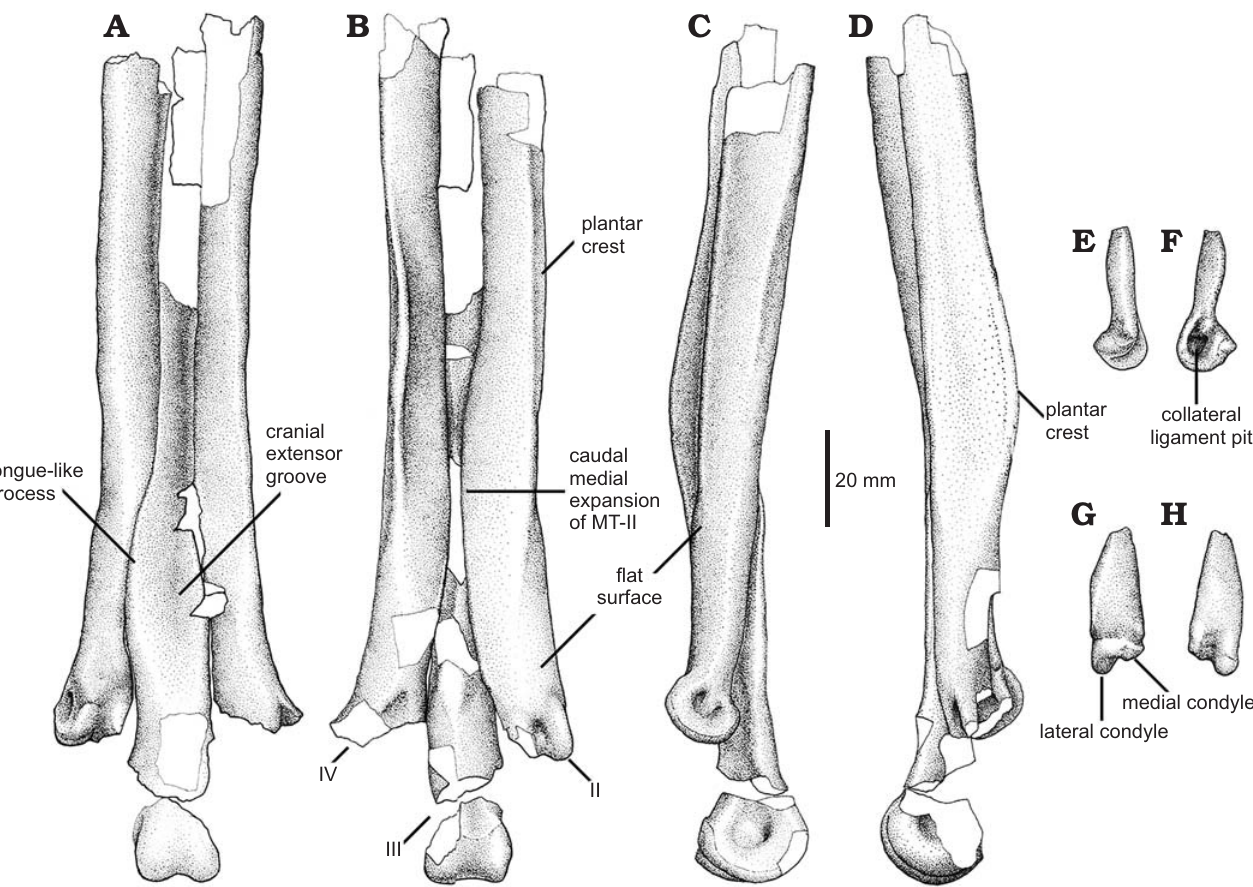
Fig. 7. Unenlagiid theropod Neuquenraptor argentinus Novas and Pol, 2005 (MCF PVPH 77) from Sierra del Portezuelo, Neuquén Province, Argentina; Portezuelo Formation, Coniacian, Late Cretaceous. A – D . Left metatarsals II–IV in cranial ( A ), caudal ( B ), medial ( C ), and lateral ( D ) views. E – H . Metatarsal I in medial ( E ), lateral ( F ), caudal ( G ), and cranial ( H )